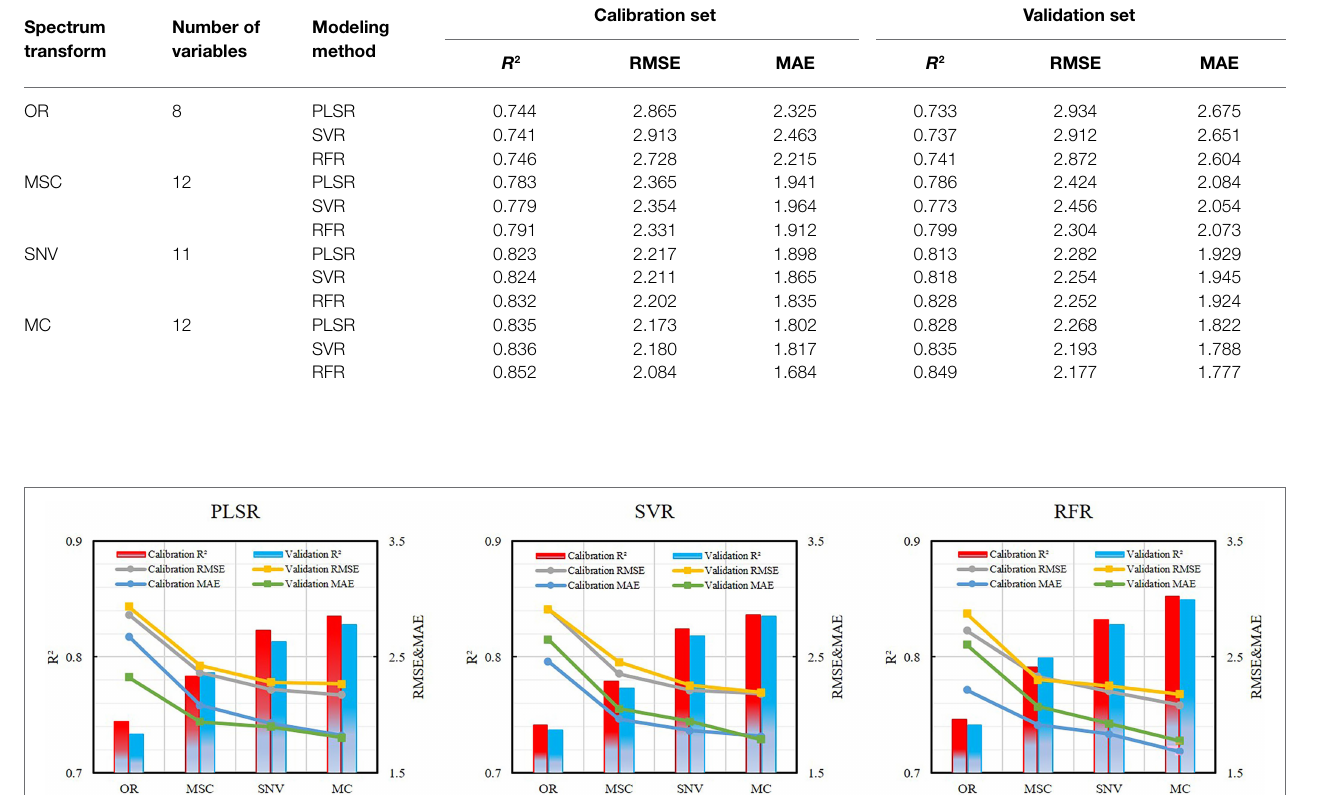
TABLE 3 | Specific metrics for machine learning models based on different spectral transformation methods. Spectrum